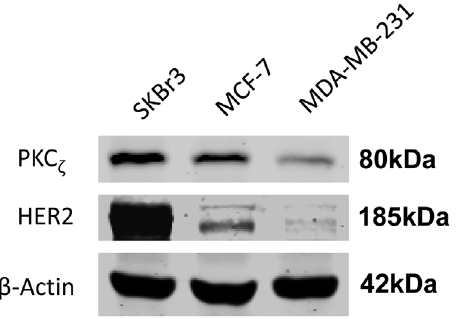
Figure 4. Positive correlation between PKC f and HER2 levels in breast cancer cell lines. Expression of PKC f and HER2 were determined using western blots. ß-actin served as a loading control.